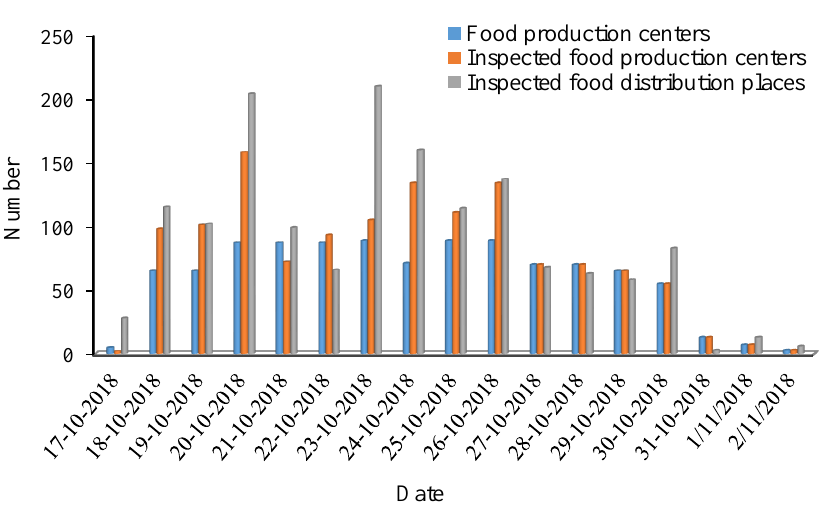
Fig. 4. Number of food production centers and inspections